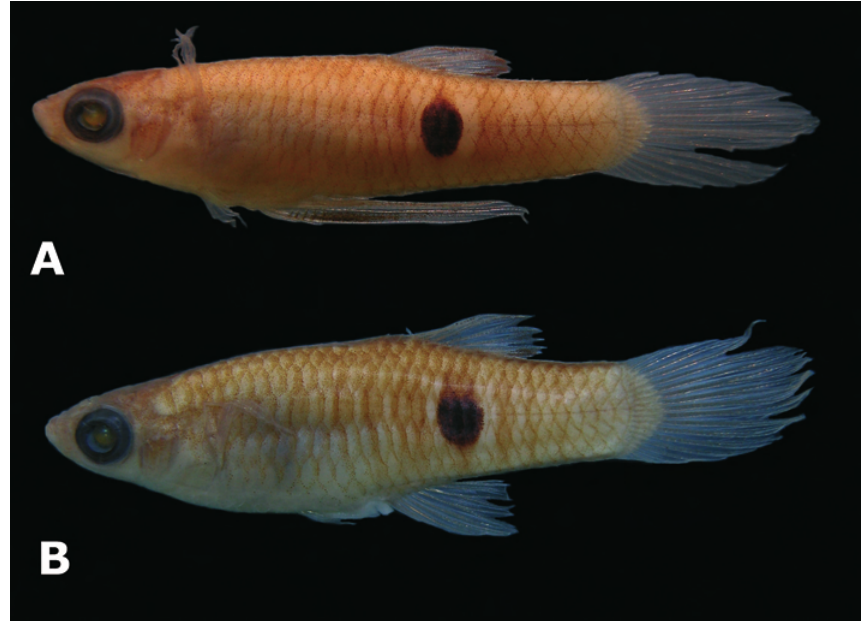
Fig. 30. Phalloceros ocellatus . (A) Holotype, male, 16.3 mm SL, MCP 30549, fourth stream flowing east at 26 km from Prado on road from Prado to Cumuruxatiba. Prado, Bahia, Brazil; (B) paratype, female, MCP 30548, 24.4 mm SL, collected with the